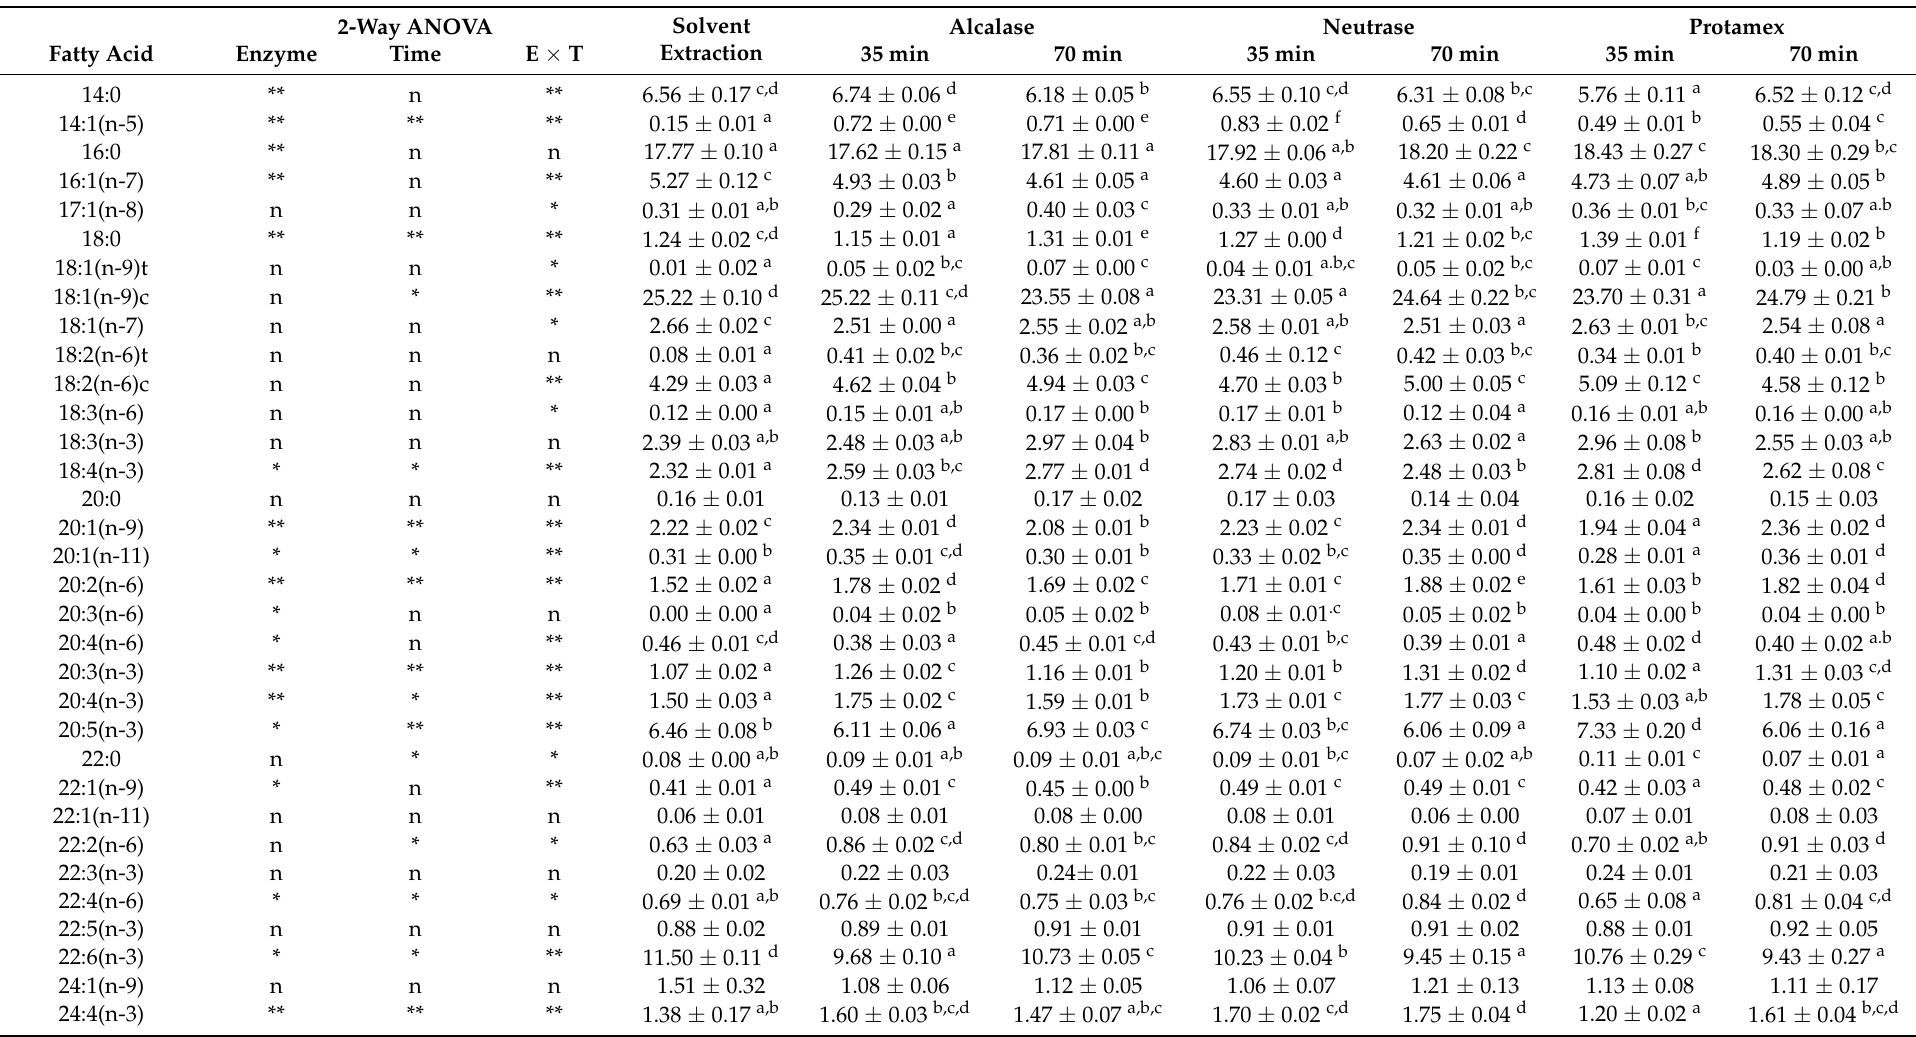
Table 2. Fatty acid composition of enzymatically extracted oils and solvent-extracted oil (reference) from whole Baltic herring. The values are presented as mass percentages of the total fatty acid content. The results are shown as mean value ± standard deviation of the three analytical replicates. 2-Way ANOVA Solvent Alcalase Neutrase Extraction